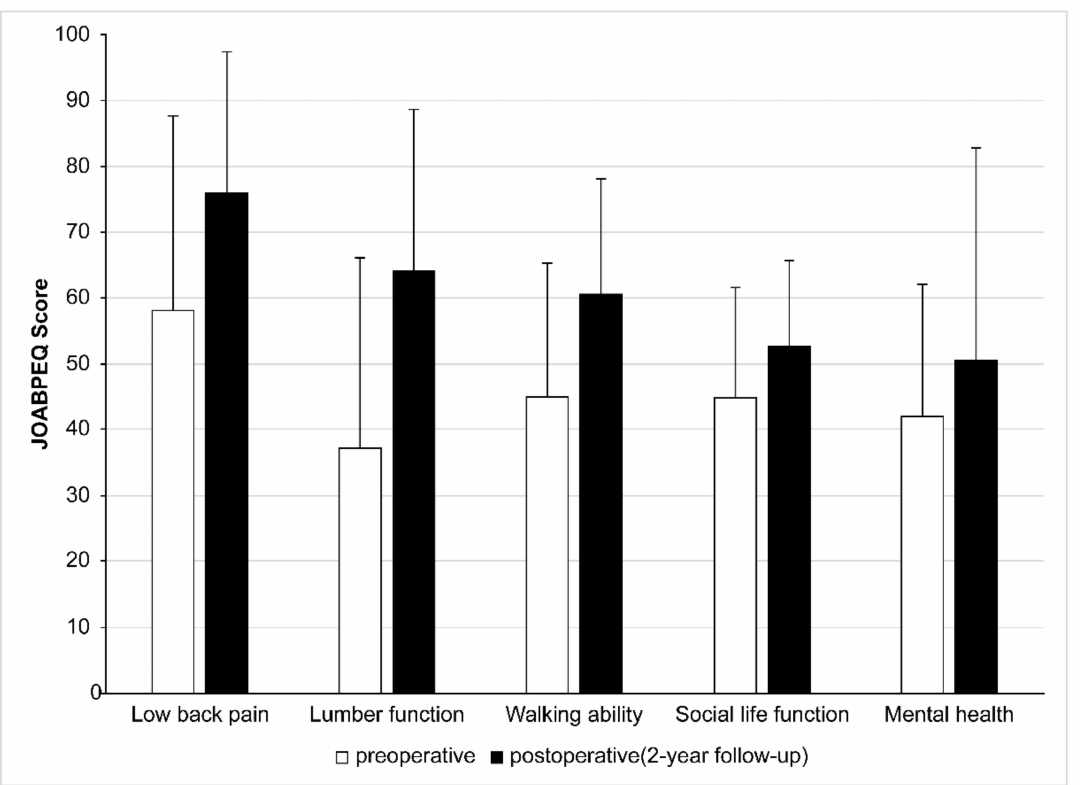
Figure 3. JOABPEQ in POSDe with the three-step wanding technique. JOABPEQ in POSDe improved in each category significantly (2-year follow-up, p = 0.05). JOABPEQ, Japanese Orthopedic Association Back Pain Evaluation Questionnaire; POSDe, posterior oblique square